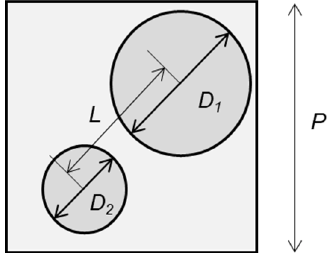
Figure 7. Two nanodots formed in a square grid.